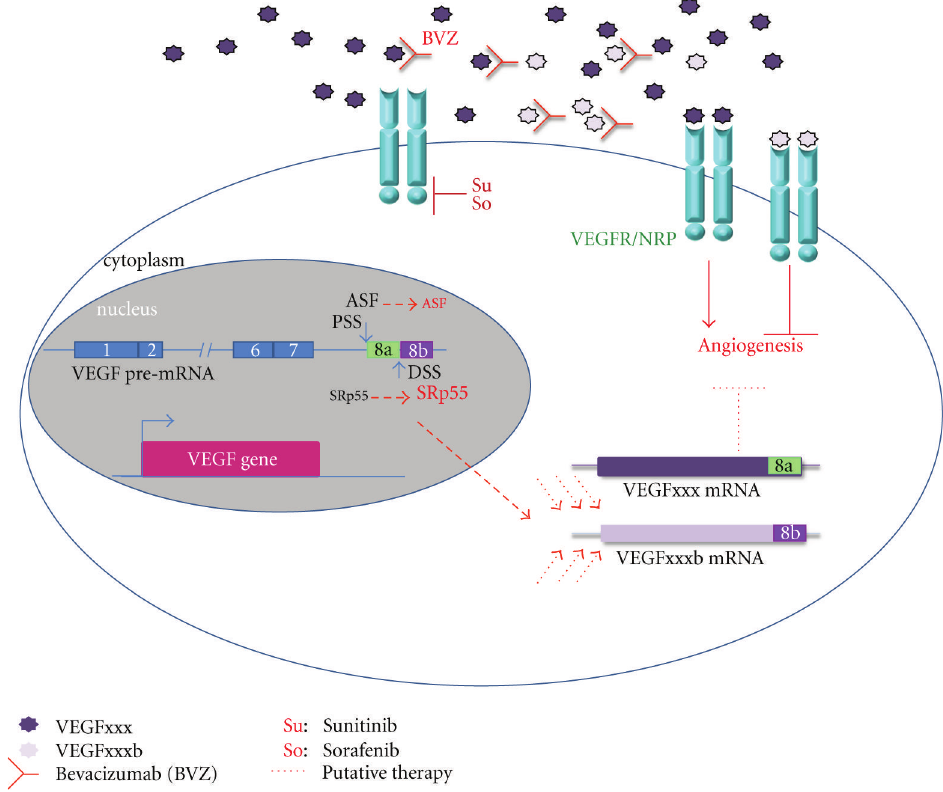
Figure 2: Existing and putative therapies targeting angiogenesis in RCC. VEGFxxx forms homodimers and interacts with their receptors inducing the activation of signalling pathways leading to increased angiogenesis. Homodimers of VEGFxxxb can bind the receptors blocking angiogenesis. However, the existence and function of potential VEGFxxx/VEGFxxxb heterodimers remain unclear. The monoclonal antibody Bevacizumab targets VEGFxxx blocking the VEGFR signalling pathways but also interacts with VEGFxxxb. Sorafenib and Sunitinib are Receptor Tyrosine Kinase inhibitors that interact with the kinase domain of VEGFR and thus inactivate the downstream signalling pathways. The VEGF gene is transcribed into a pre-mRNA that undergoes di ff erent splicing events leading to di ff erent isoforms. Splicing at Exon 8 will determinate the pro- or anti-angiogenic property of the produced protein. Hence, the use of the proximal splicing site (PSS) by in particular the splicing factor ASF/SF2 leads to pro-angiogenic -VEGFxxx- forms while the use of the distal splicing site (DSS) by another SR protein, SRp55 provides the anti-angiogenic -VEGFxxxb- forms. Combining all of this knowledge leads to propose that by acting on the VEGFxxx/VEGFxxxb ratio through the modulation of splicing, we could modify the angiogenic potential.